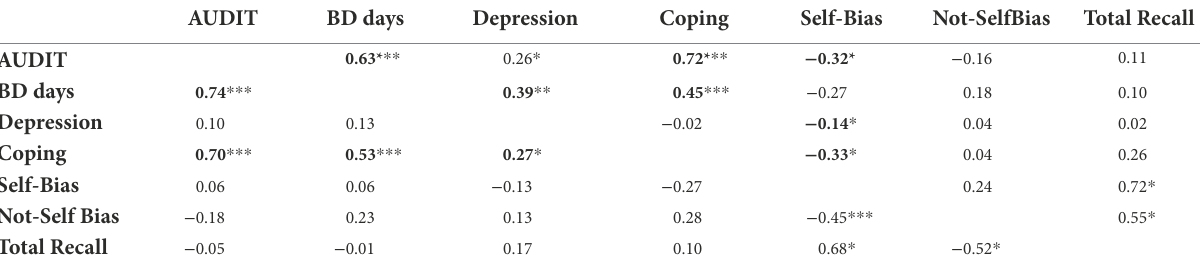
TABLE 4 Correlation matrix for females (below diagonal) and males (above) in the community sample for alcohol, clinical, and memory variables of interest in Study